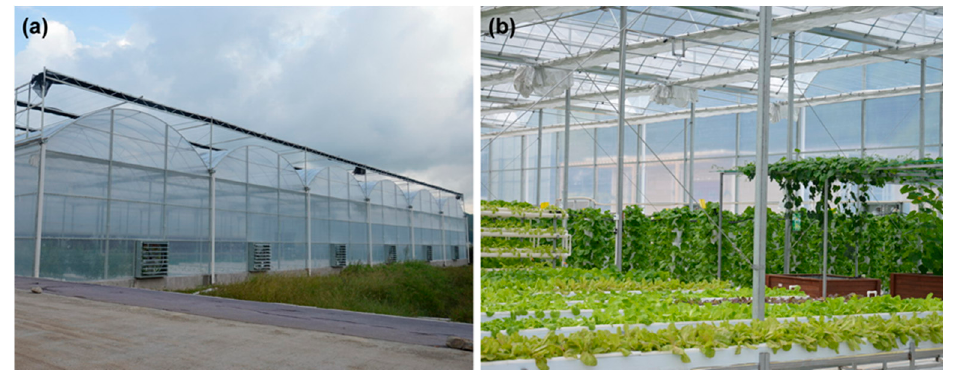
Figure 8. ( a ) Illustration of the appearance of the experimental greenhouse; ( b ) Illustration of the inside structure for the experimental greenhouse.